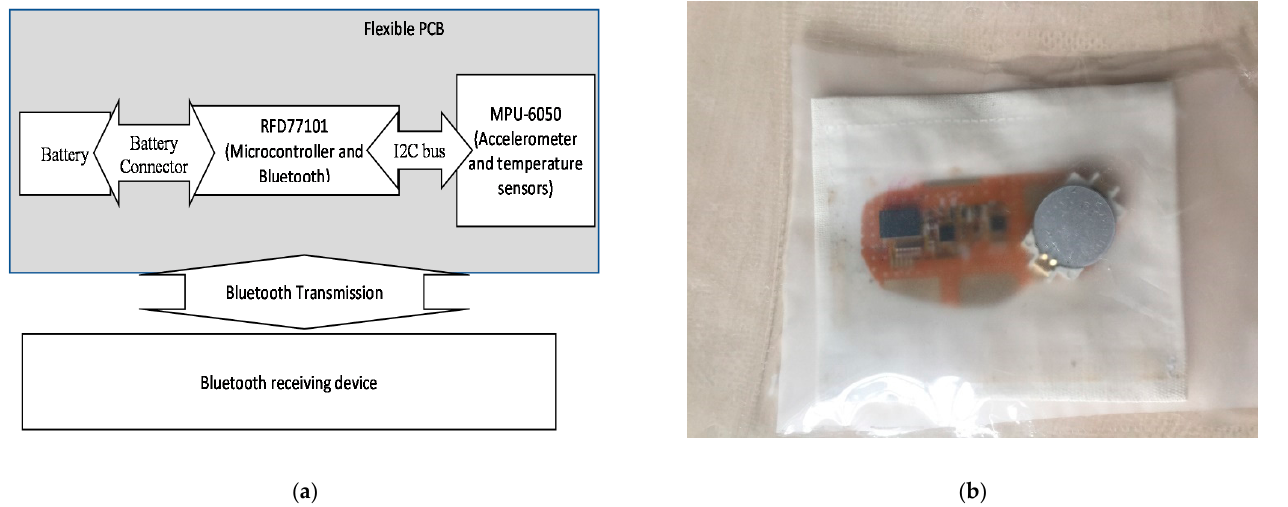
Figure 2. ( a ) Accelerometer diagram. ( b ) An accelerometer is sealed in an airtight envelope. PCB: printed circuit board.